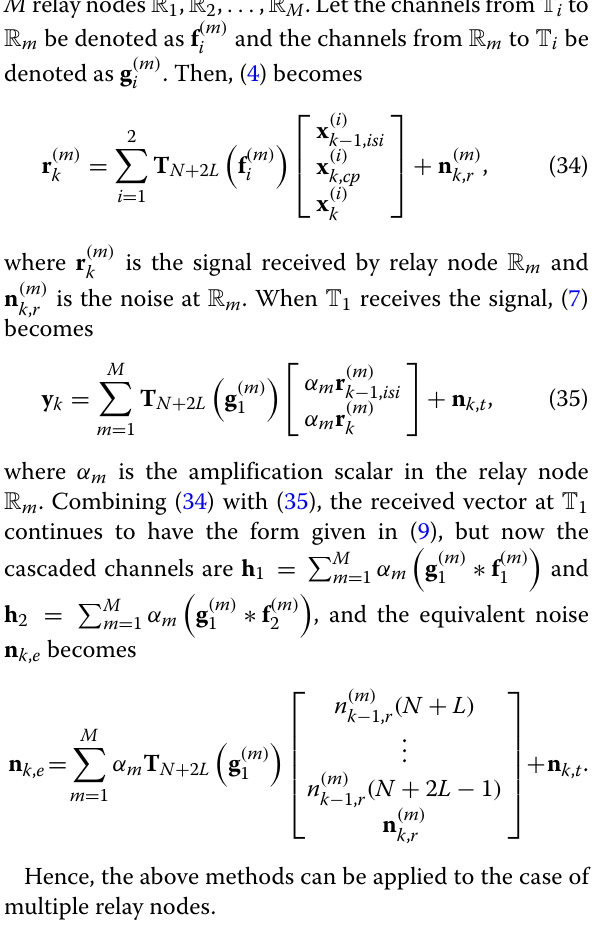
T R i to m be denoted as f